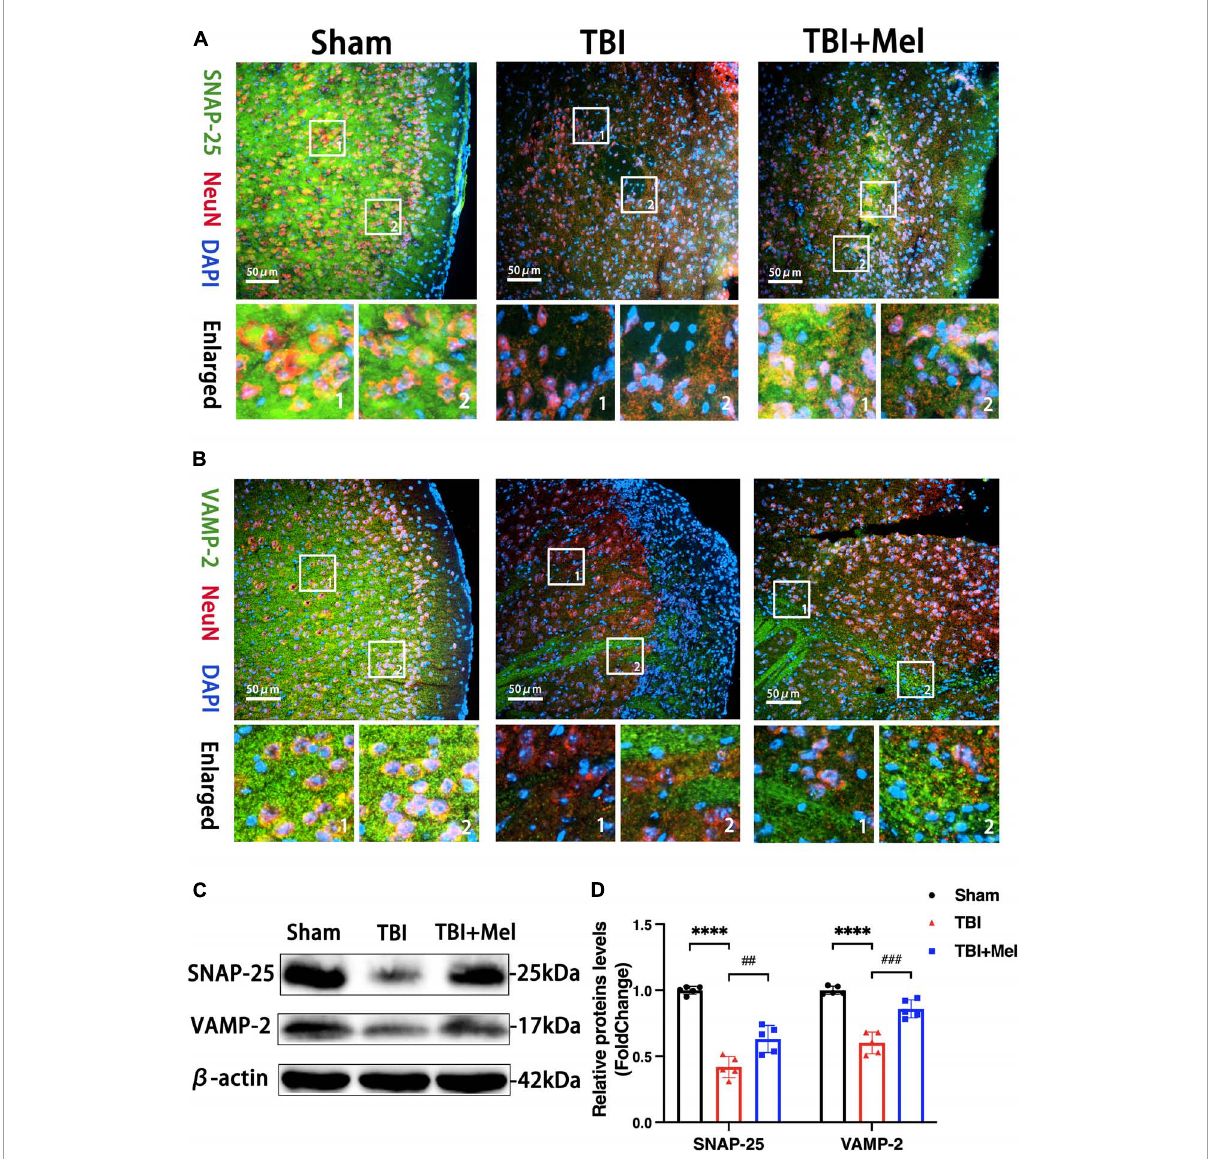
FIGURE9 Melatonin improves the synaptic function after TBI. (A,B) The distributions of SNAP-25 and VAMP-2 were detected by immunofluorescent staining. The scale bar represents 50 µ m. (C,D) The expressions of SNAP-25 and VAMP-2 in the sham, TBI, and TBI + Mel groups were detected by Western blot. n = 5 mice per group. SNAP-25: **** p < 0.0001 TBI vs. Sham; ## p < 0.01 TBI + Mel vs. TBI, one-way ANOVA followed by Tukey’s test. VAMP-2: **** p < 0.0001 TBI vs. Sham; ### p < 0.001 TBI + Mel vs. TBI, one-way ANOVA followed by Tukey’s